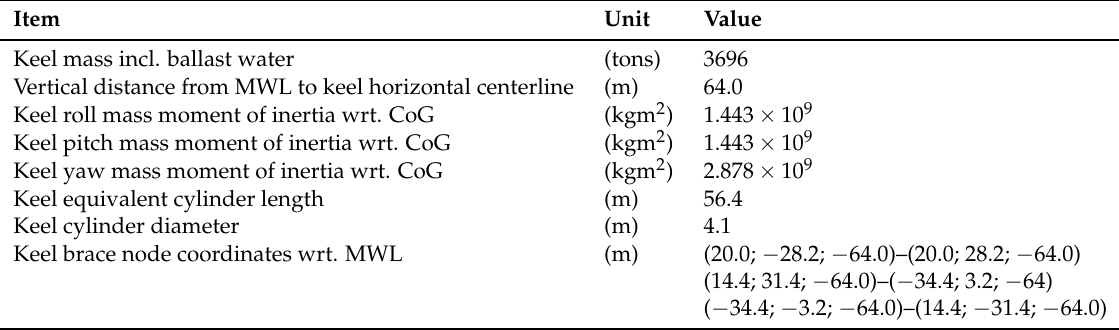
Table 6. Properties of the keel structure.